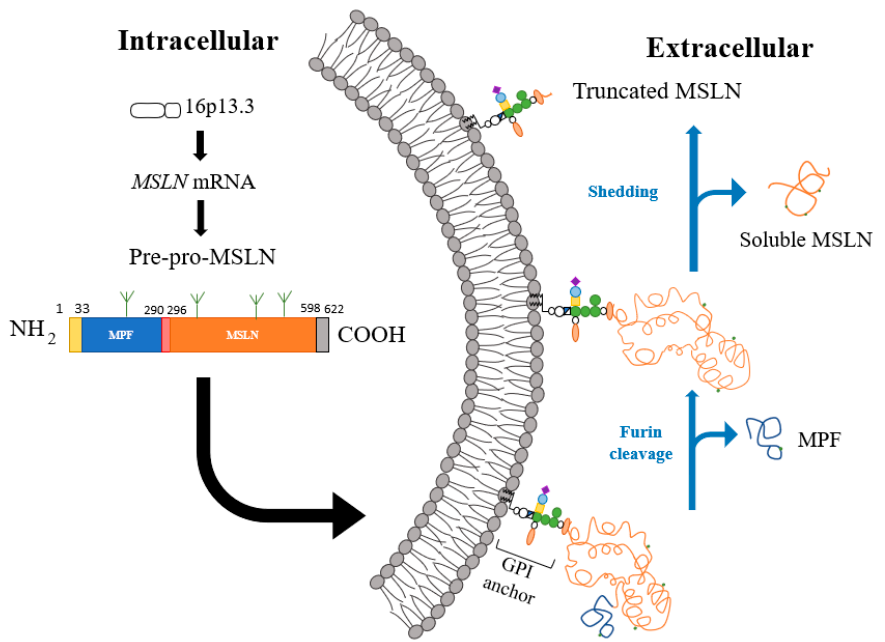
Figure 1. Mesothelin processing produces mature cell-surface mesothelin and megakaryocyte po- tentiating factor (MPF). The MSLN gene is located at 16p13.3 and encodes for the MSLN mRNA. The pre-pro-mesothelin consists of a signaling peptide at the N-terminus (yellow), mature MPF (blue), furin cleavage site (red), mature mesothelin (orange), and a GPI-anchor sequence (gray). Along the pre-pro-mesothelin, there are four glycosylation sites (green), three of which exist on the mature mesothelin domain. Once on the surface, mesothelin gets docked to the cell membrane with a glycosylphosphatidylinositol (GPI) anchor. Mesothelin processing continues when furin (or other ap- plicable proteases) cleaves the pre-pro-mesothelin to result in soluble MPF and a mature mesothelin. Finally, mesothelin can undergo membrane shedding and result in a truncated mesothelin protein still left on the cell surface as well as soluble mesothelin.